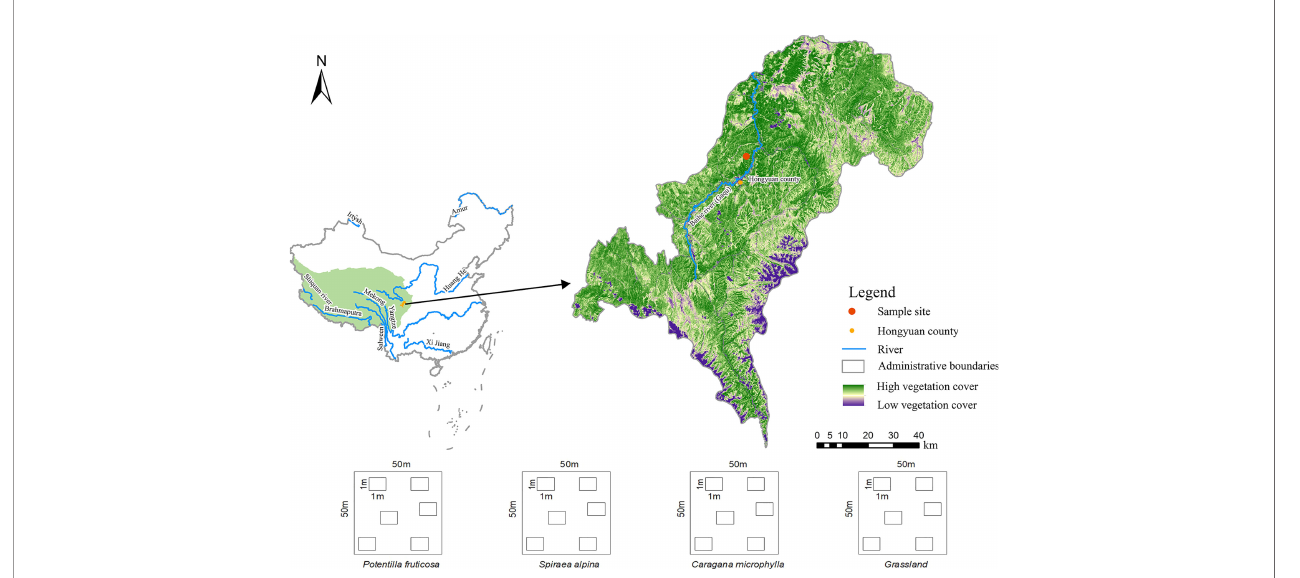
FIGURE 1 | The map of sampling sites and experimental